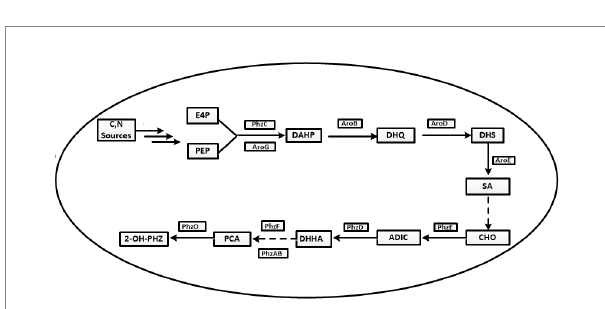
FIGURE 1 The synthetic pathway of phenazine-1-carboxylic acid and its derivatives in Pseudomonas chlororaphis . E4P, erythrose 4-phosphate; PEP, phosphoenolpyruvic acid; DAHP, 3-deoxy- darabinoheptulosonate-7-phosphate; DHQ, 3-dehydroquinic acid; DHS, 3-dehydroshikimic acid; SA, shikimic acid; CHO, chorismate; ADIC, 2-amino-4-deoxy branched acid; DHHA, Trans-2,3-dihydro- 3-hydroxyanthranilic acid; PCA, Phenazine-1-carboxylic acid; 2-OH- PHZ, 2-hydroxyphenazine.